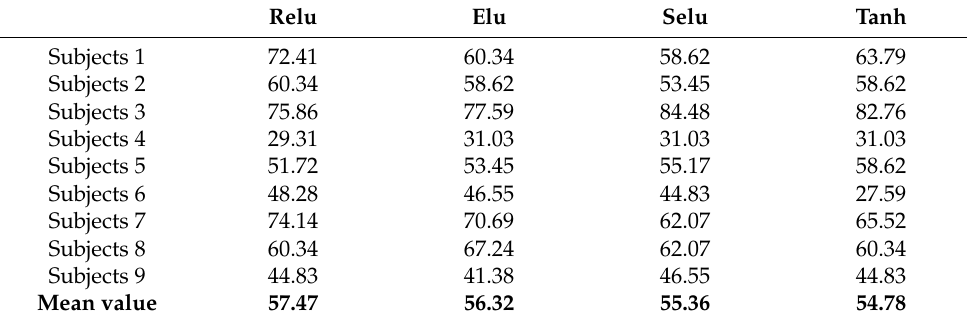
Table 2. Classification accuracy of the proposed ANN methods (%).